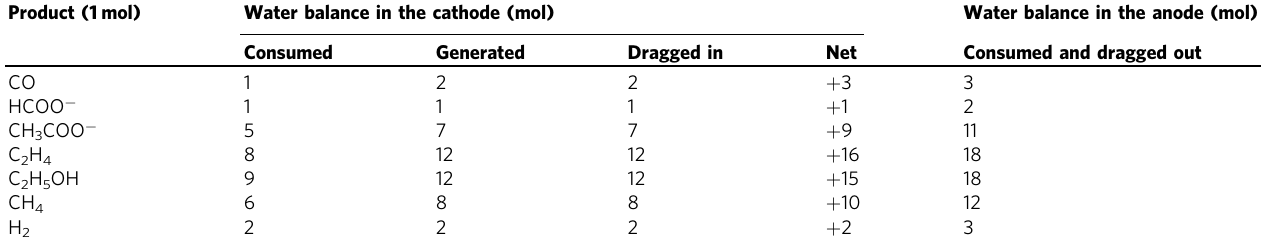
Table 2 The cathode-anode water balance in an SC-CEMEA. Product (1